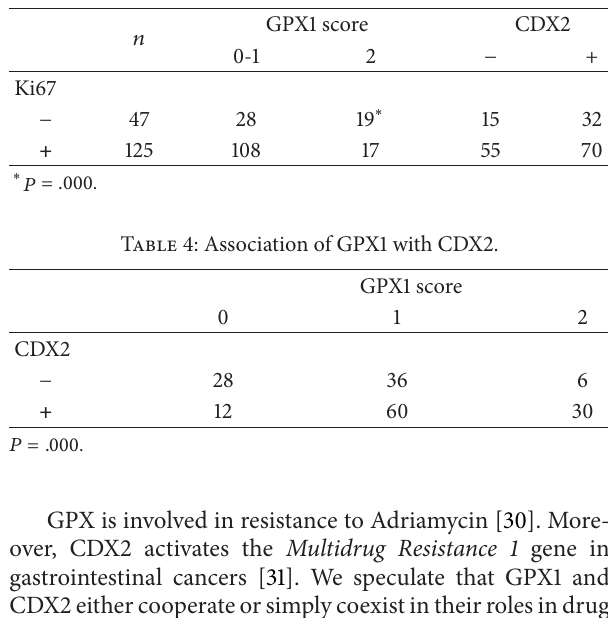
Table 3: Association of GPX1 and CDX2 with Ki67 in GAC.